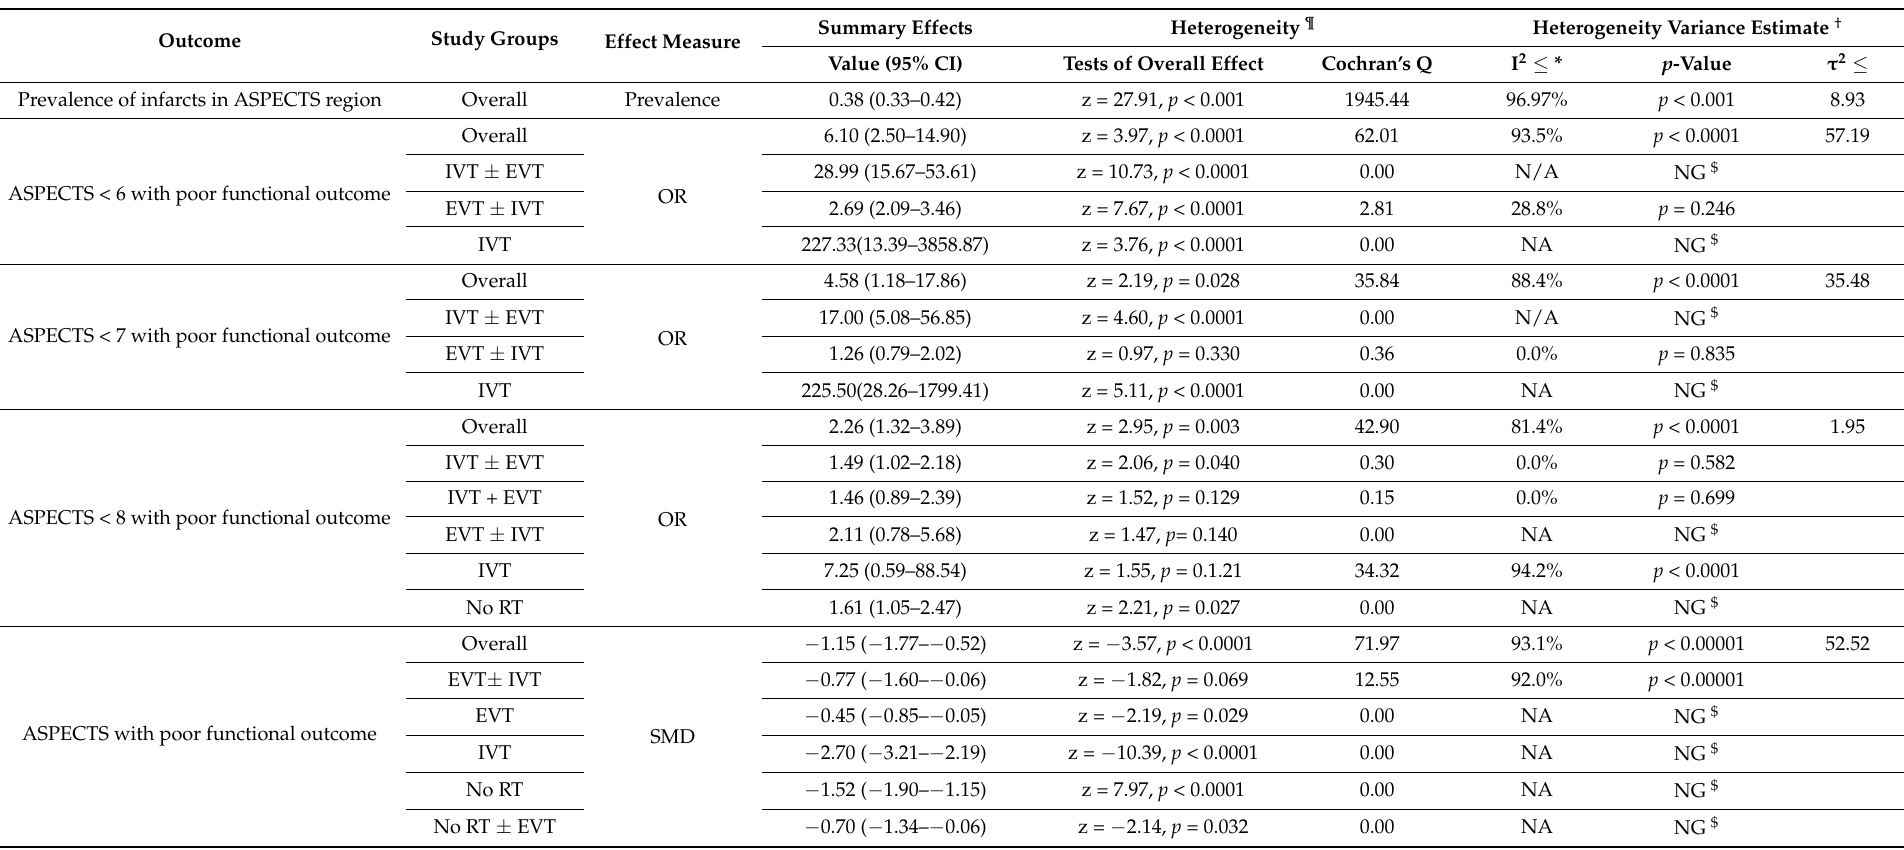
Table 2. Summary effects and heterogeneity obtained from the meta-analysis of the association of ASPECTS with clinical outcomes in acute ischaemic stroke patients considered for, or receiving, reperfusion